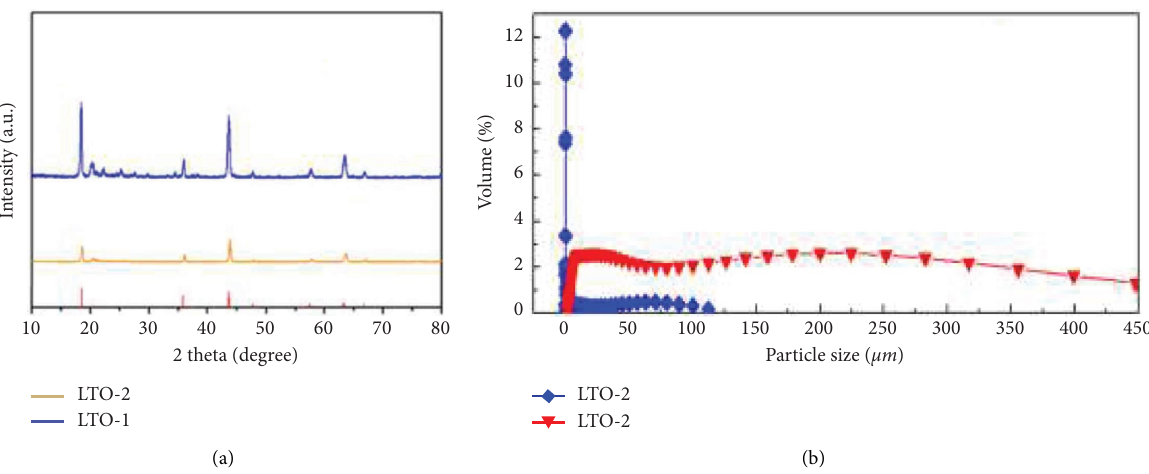
Figure 3: Comparison between LTO-1 and LTO-2. (a) XRD patterns; (b) particle size distribution diagram.